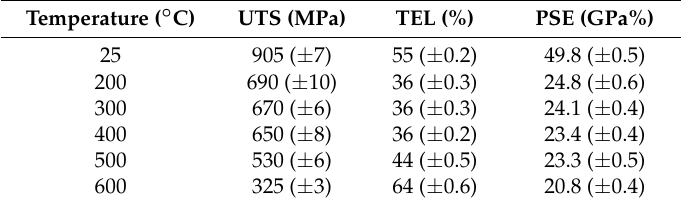
Table 1. Mechanical properties of experimental steel at different tensile test temperatures.